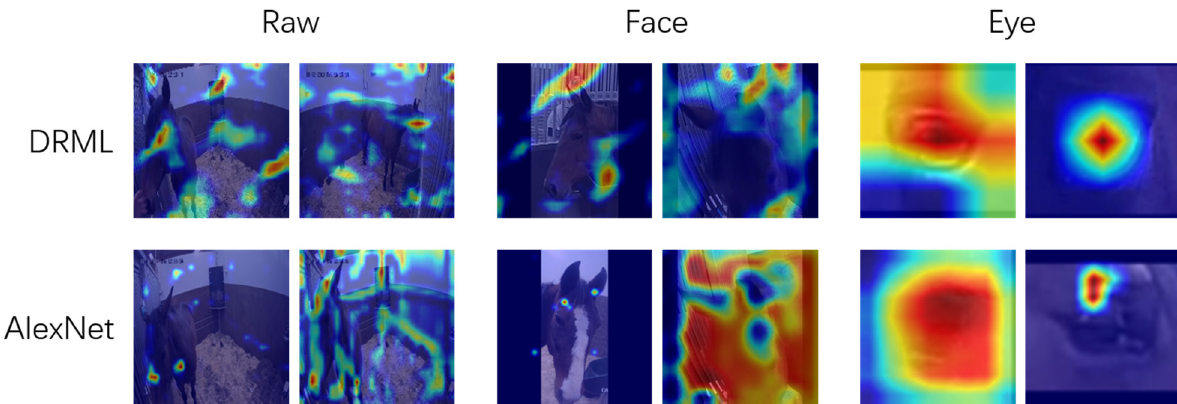
Figure 2. Grad-CAM saliency maps of the models for binary classification of action unit AU101. When raw images were used (left), neither the DRML nor AlexNet model could identify AU101. When the eye region was extracted as a region-of-interest (right), the activity of AU101 was detected by both models but was most recognizable in the AlexNet image, lower row, last image. From [110]. A video clip with an example of AU101 is given in the Supplementary Material.